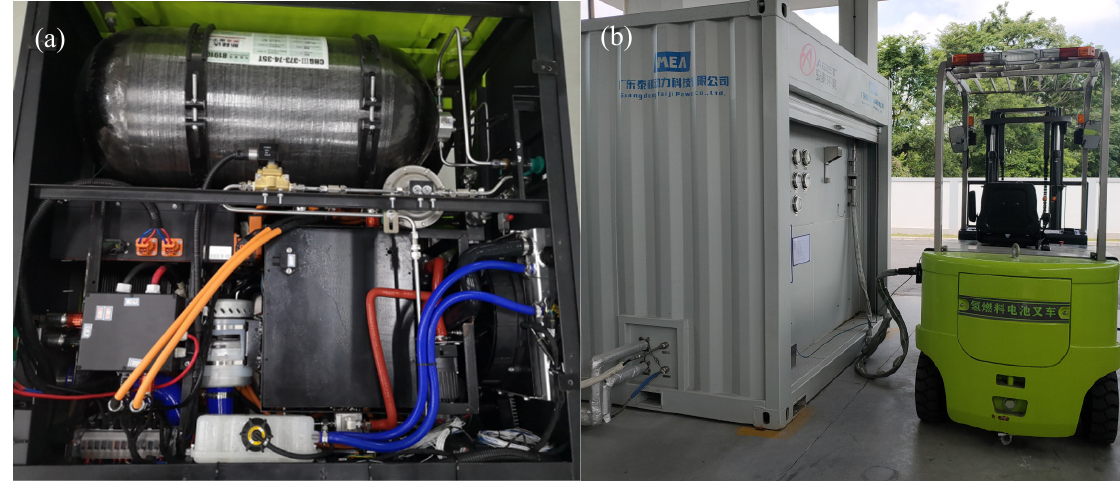
Figure 2. Fuel cell system and Refueling for the PEMFC powered forklift.